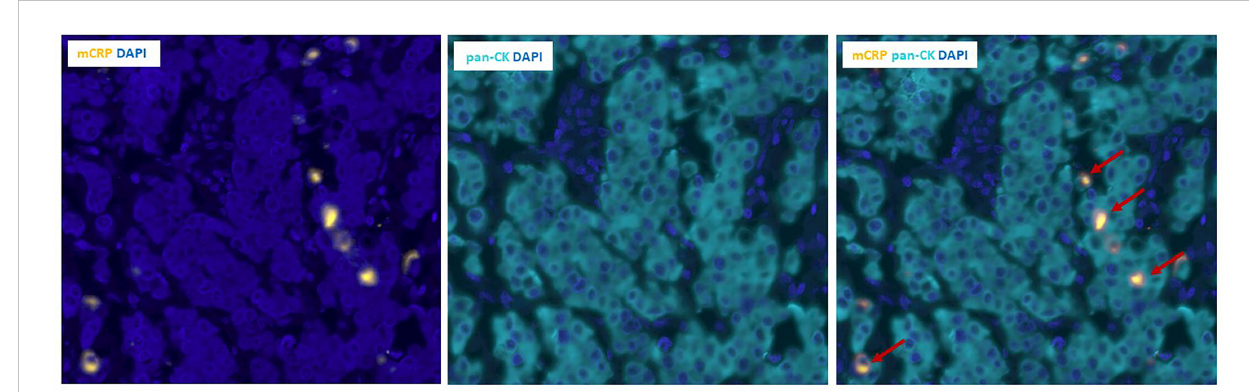
FIGURE 6 Double immuno fl uorescence labeling of mCRP and tumor cells in colon cancer tissue. Left and middle panels: Unmixed images showing individual stains of mCRP (yellow) to the left and pan-CK positive tumor cells (teal) in the middle. Right panel: Composite image showing double positive mCRP+/pan-CK+ tumor cells (marked by arrows). DAPI (blue) was used for visualization of nuclei. Pan-CK,